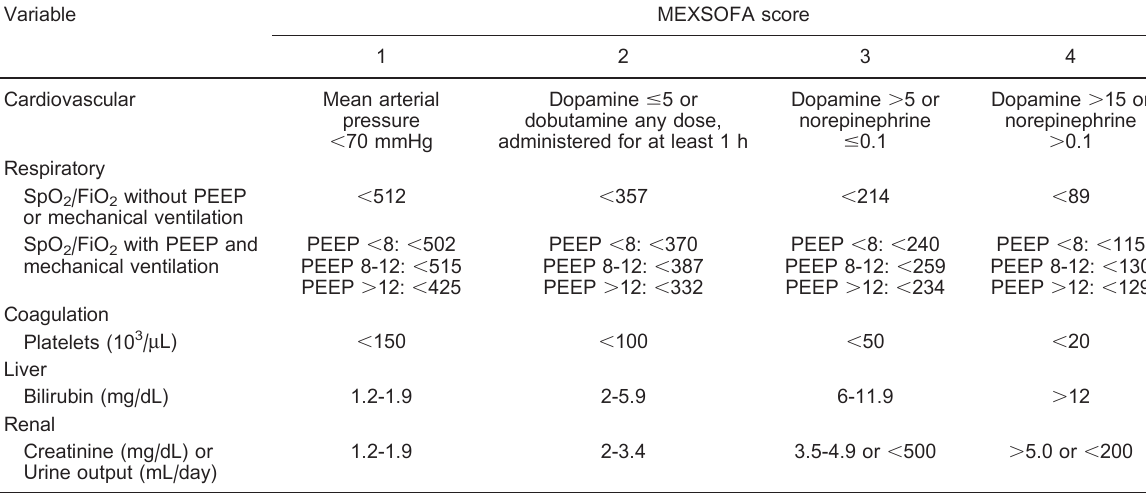
Table 1. The Mexican sequential organ failure assessment (MEXSOFA) score.